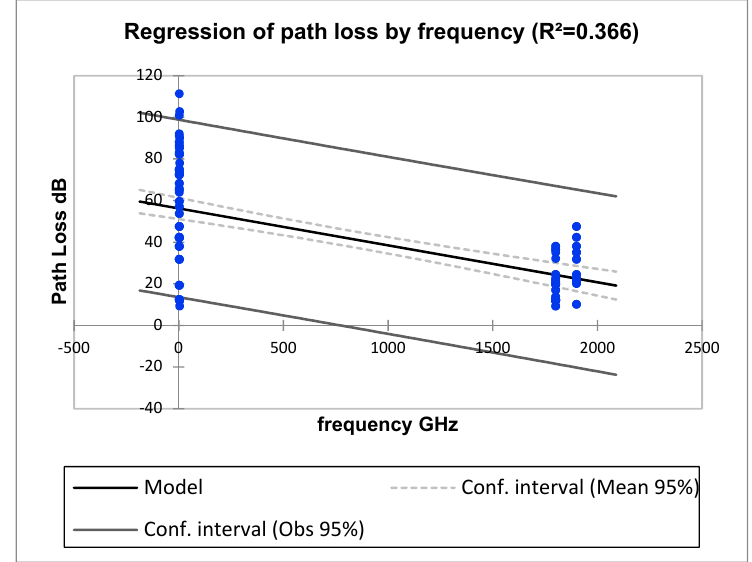
Figure 8. Regression of Path Loss by Frequency.